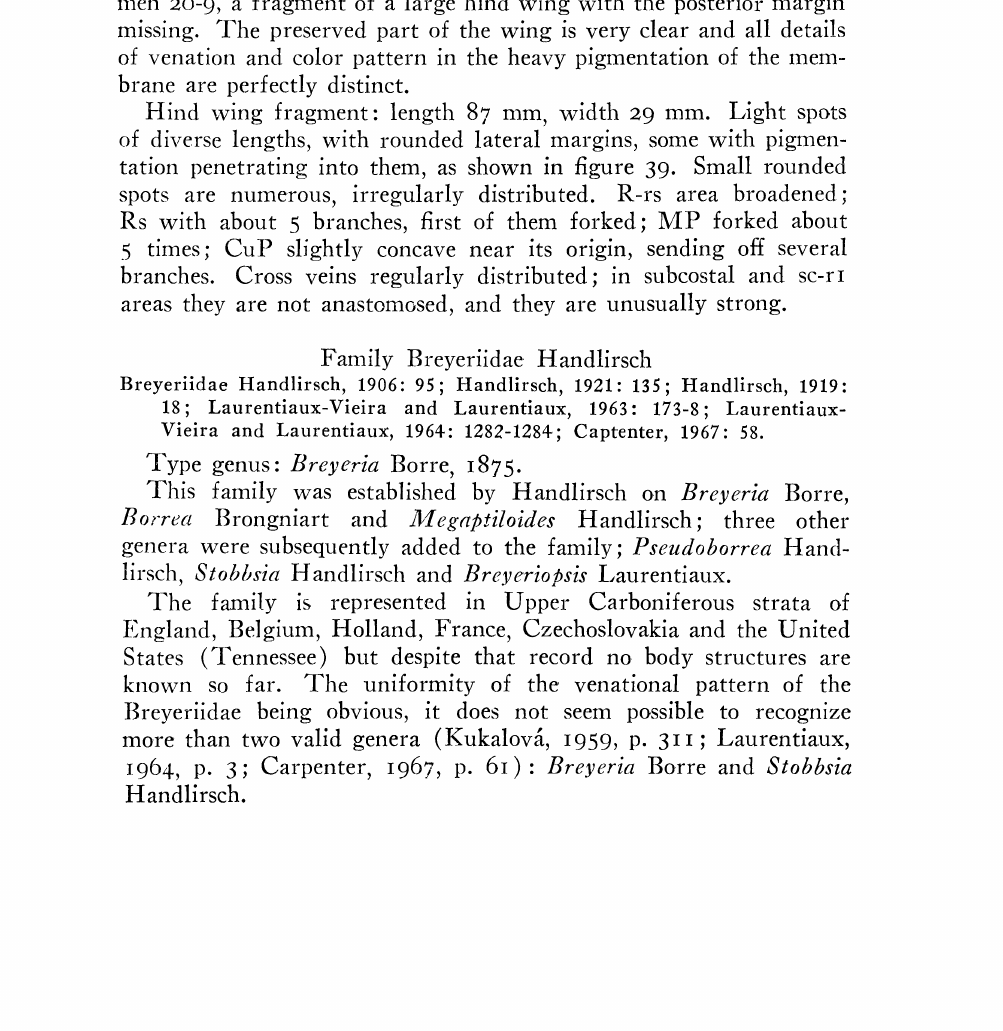
Figure 39 Rhabdoptilus ed,wardsi Brongniart, 1893: 365, pl. 20, fig. 9;